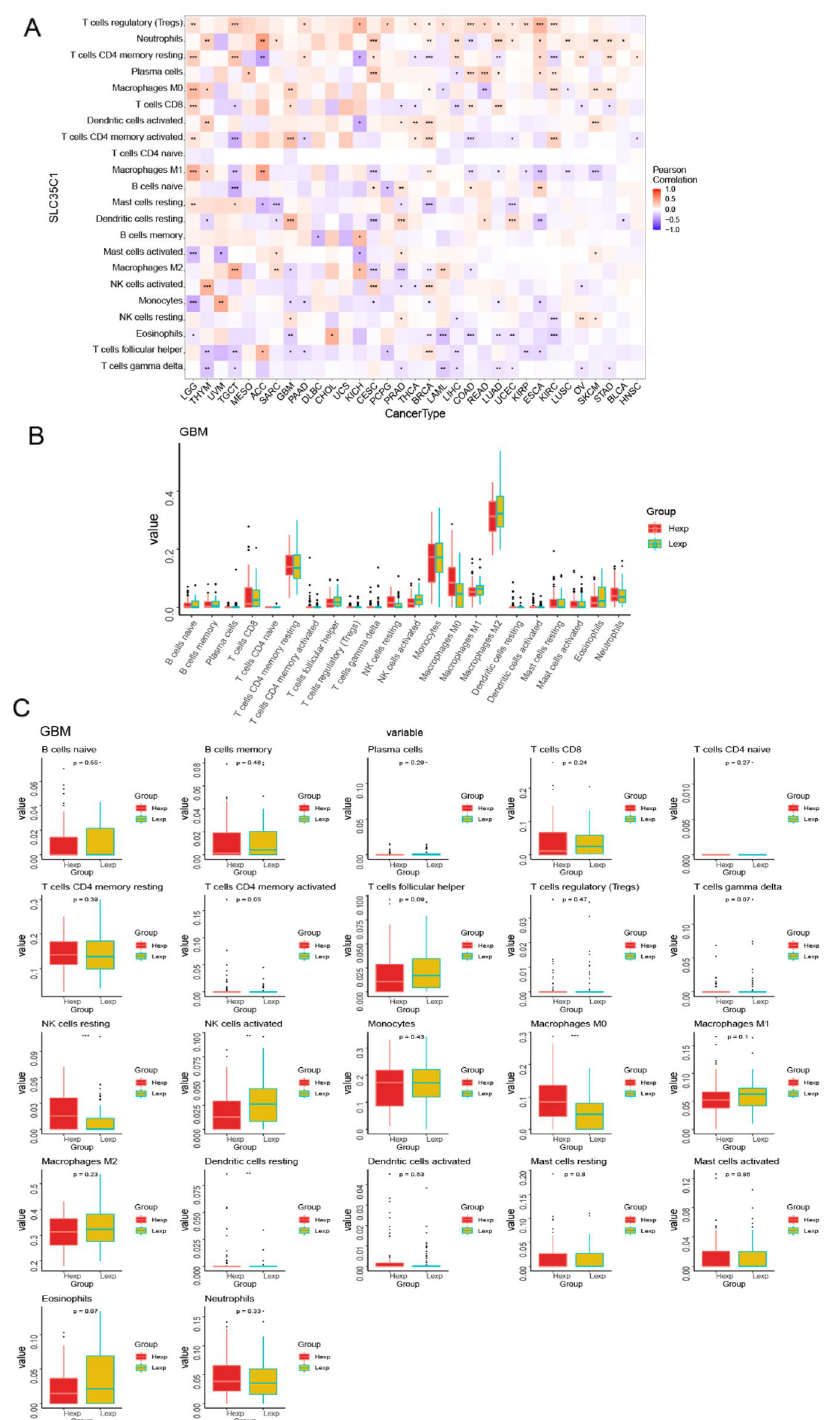
Figure 5. SLC35C1 expression is correlated with cancer immunity. ( A ) Correlation between the expression of SLC35C1 and infiltration by 22 types of immune cells in pan-cancer analysis. Red denotes a correlation coefficient > 0, whereas blue denotes a correlation coefficient < 0. ( B , C ) The statistical chart after using the CIBERSORT method shows the proportion difference of immune cell between SLC35C1 high and low expression groups in ovarian cancer. Red represents the high SLC35C1 expression group, yellow represents the low SLC35C1 expression group. *P < 0.05; **P < 0.01; ***P < 0.001. ns, no